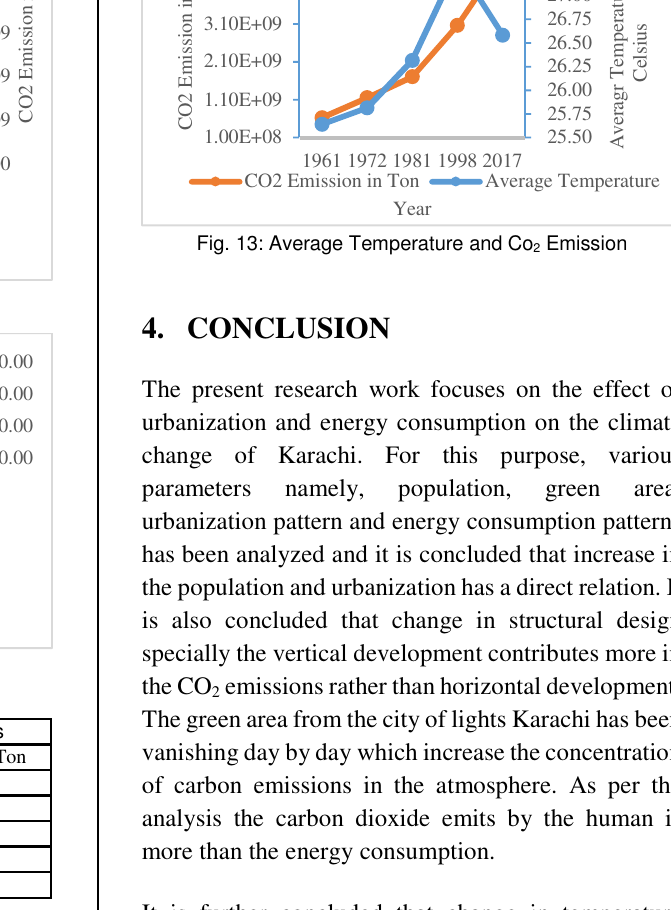
Fig. 11: Co 2 Emission from Population